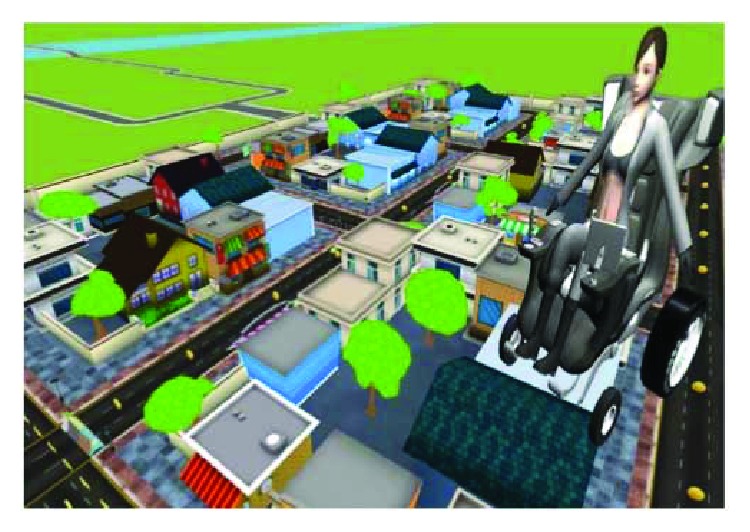
Virtual environment.